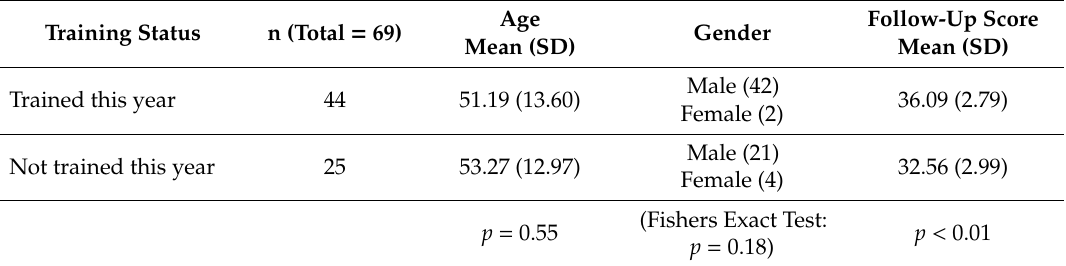
Table 5. Follow-up / focus group participant demographics and examination